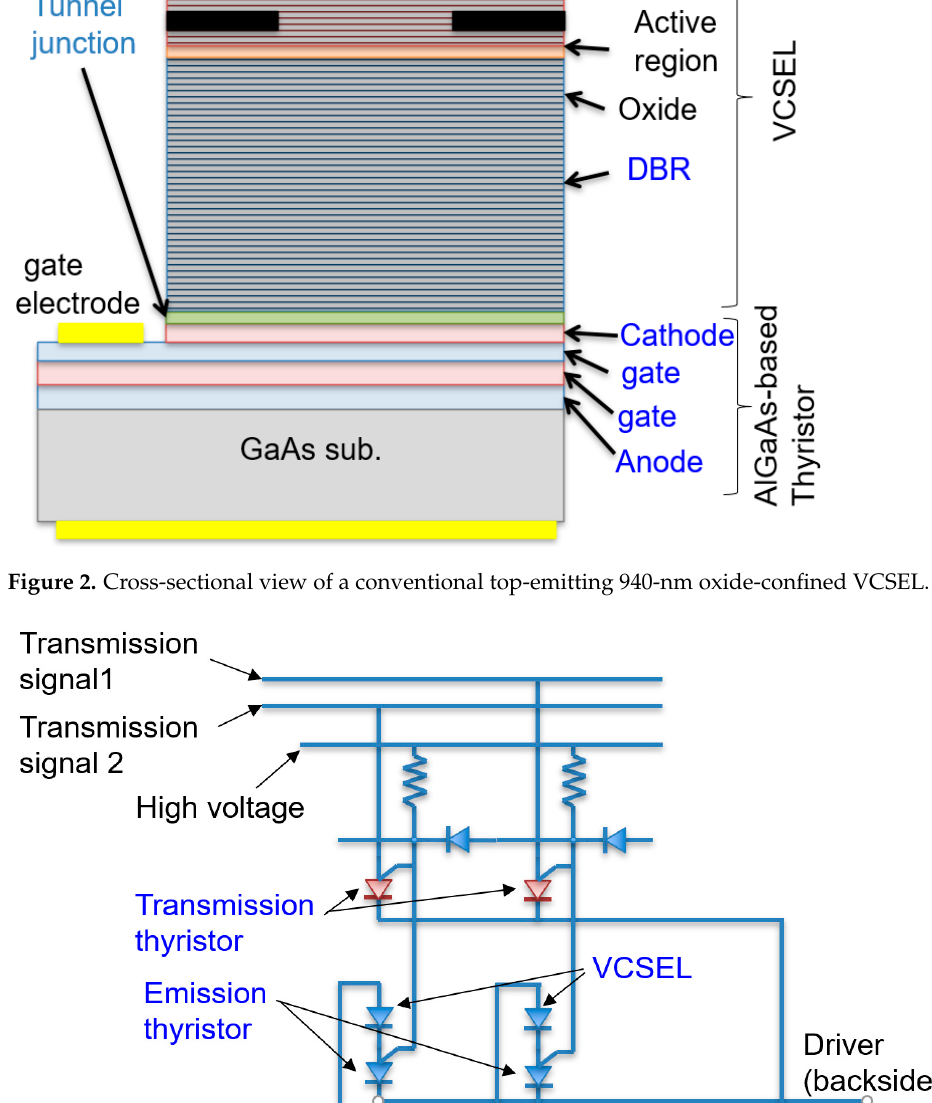
Figure 4. Schematic drawing of the proposed all-monolithically integrated self-scanning addressa- ble VCSEL array for ToF measurement.